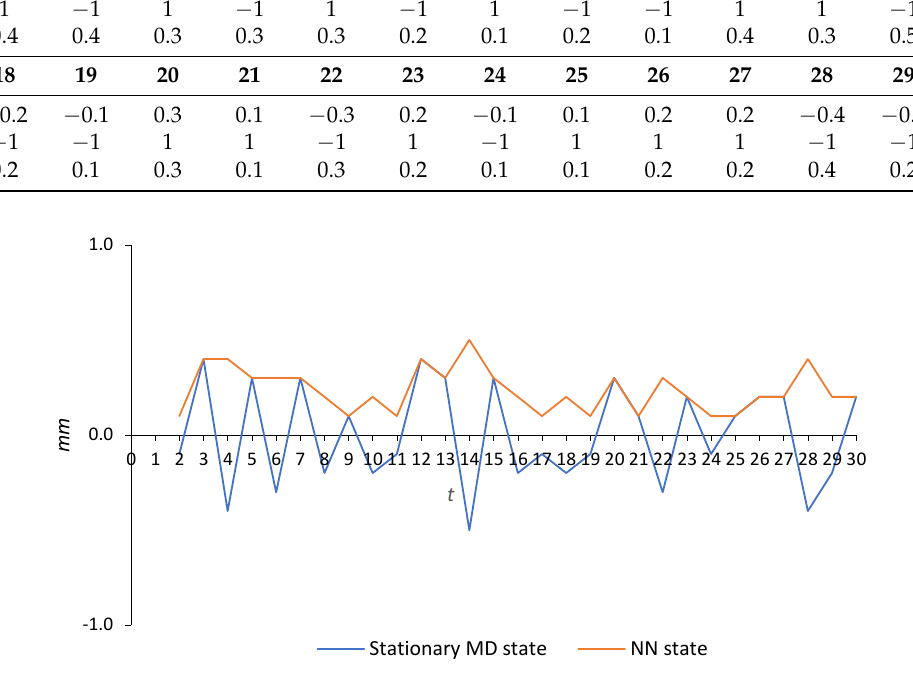
Figure 8. Transformation of stationary MD state of series.